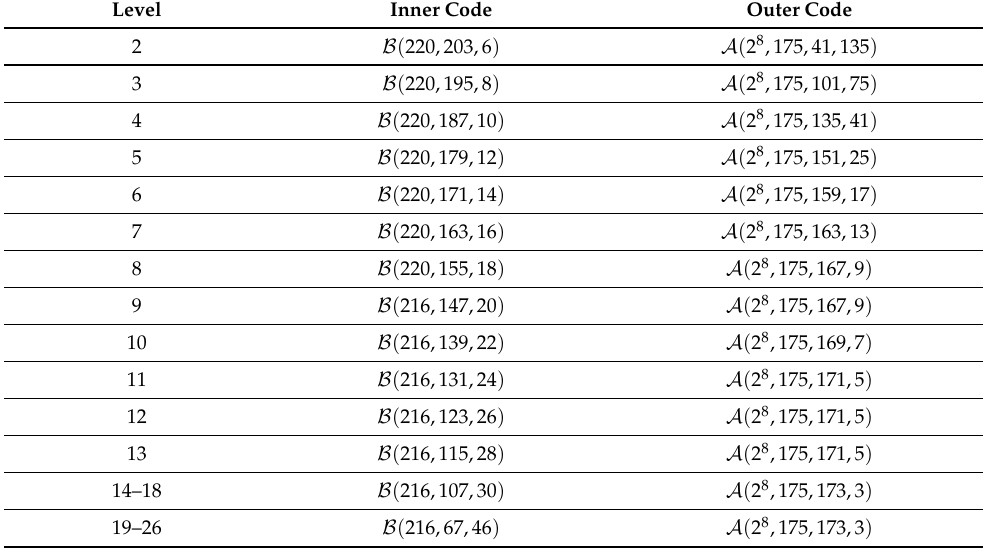
Table 6. Exemplary GC code ( N = 38,500, K = 32,773, R ≈ 0.85) for QLC (designed for WER 10 − 16